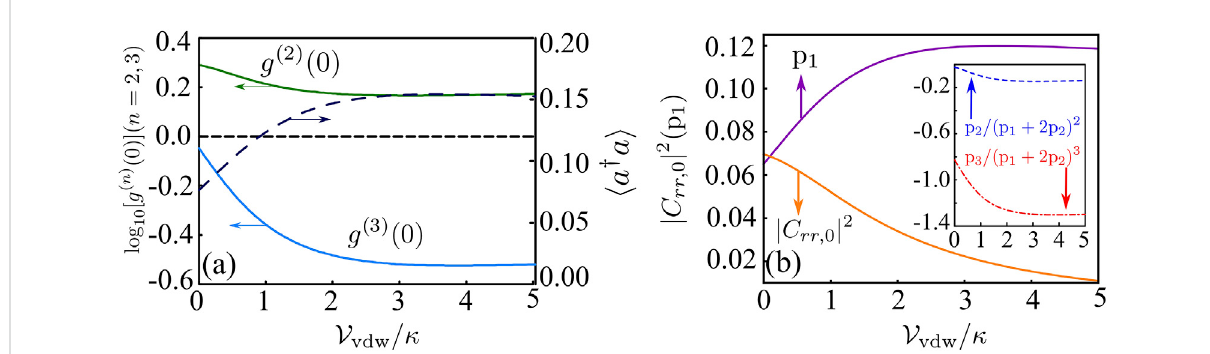
FIGURE 3 (Color online) (A) log 10 [ 〈 a † a 〉 ](blue-blackdashed curve),log 10 [ g (2) (0)] (green solidcurve), andlog 10 [ g (3) (0)](wathet blue solidcurve) are plotted as functions of the Vdw interaction strength V vdw / κ for Φ z = 0. (B) Probability of the product state | rr , 0 〉 and one-photon distributions p 1 versus the κ . The inset is the logarithmic plot(of base 10) of the proportional relationshipwhichis described in Eq. 3. System parameters used here are the V vdw / same as in Figure